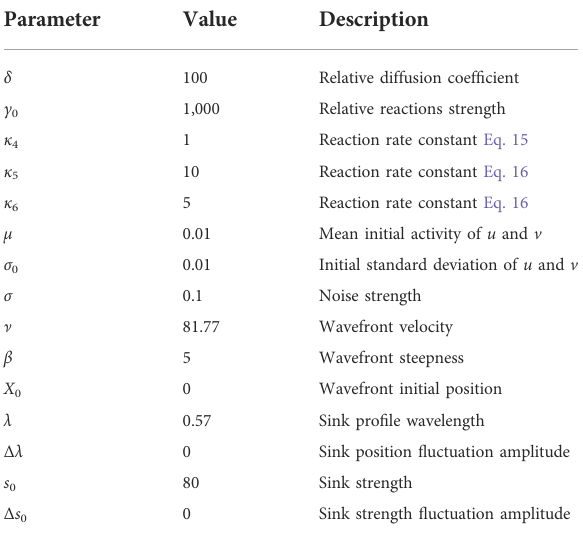
TABLE 1 Reaction wavefront theory dimensionless parameters: default values and description. Model parameters